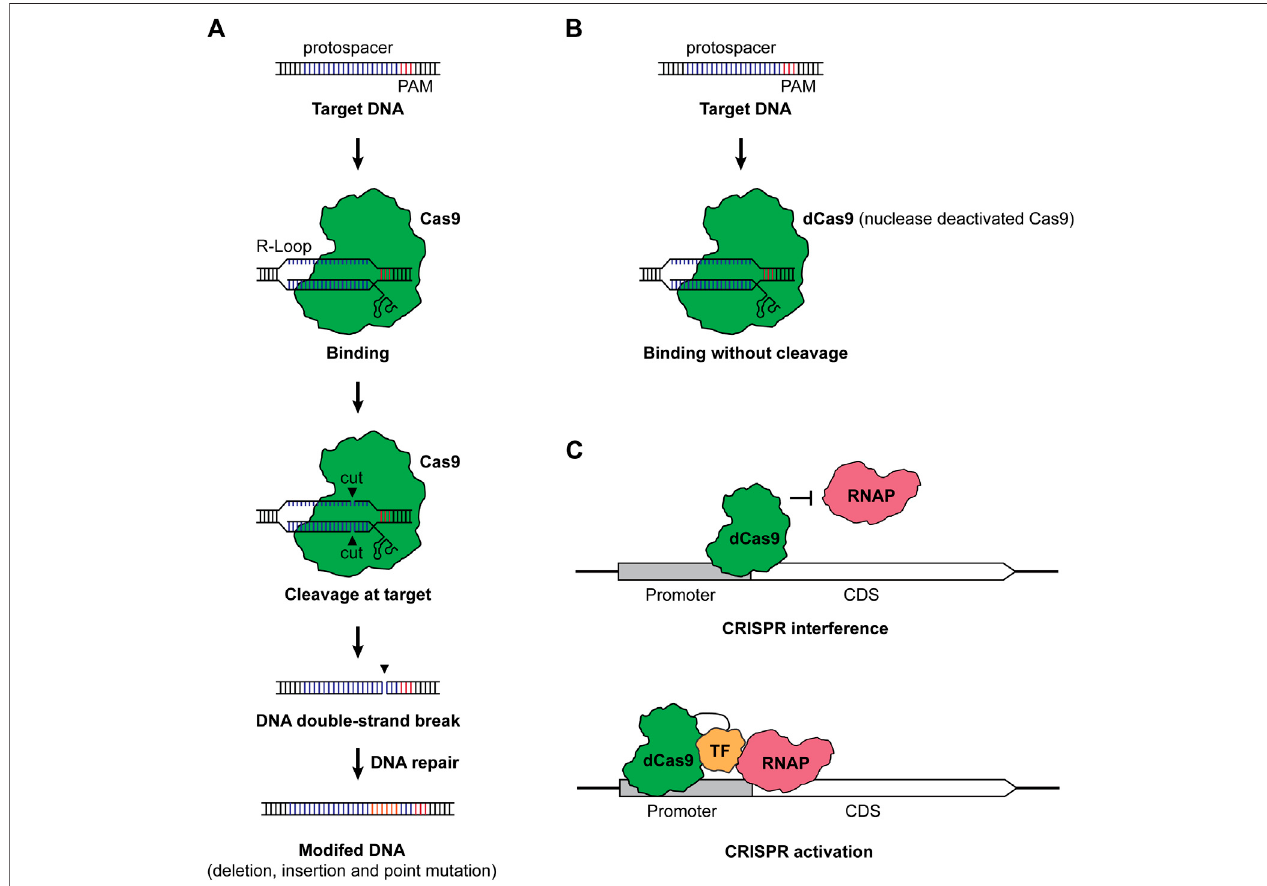
FIGURE 1 | (A) CRISPR-Cas-based genome editing. Under the guidance of a gRNA containing a spacer complementary to the protospacer and a scaffold consisting of crRNA and tracer RNA, the Cas9 and gRNA complex fi nds and binds to theprotospacer with aPAM, forming an R-loop. Then, Cas9 cuts theDNA in each strand, leaving a double-strand break (DSB) in the target. Finally, the target DNA will be modi fi ed with the repair ofDSB. (B) Nuclease deactivated Cas9 protein (dCas9). When the nuclease activity of Cas protein was deactivated, the dCas9 still binds to the target sequence but it will not cleave the DNA anymore. (C) CRISPRi and CRISPRa.ForCRISPRi,dCas9bindstothepromoterorcodingregionofageneofinterestandpreventsthebindingofRNAP,resultingintherepressionoftranscription. For CRISPRa, the dCas9-transcription factor (TF) fusion binds to theup region of thepromoter. The TF helps recruitRNAP and allows the activation oftranscription. We employedCas9from S.pyogenes asarepresentativeinthe fi gure,whileagreatvarietyofCRISPRsystemscanbeusedforgenomeediting,CRISPRi,andCRISPRa.TF stands for transcription factor, RNAP stands for RNA polymerase, CDS stands for coding sequence, and PAM stands for protospacer adjacent motif.